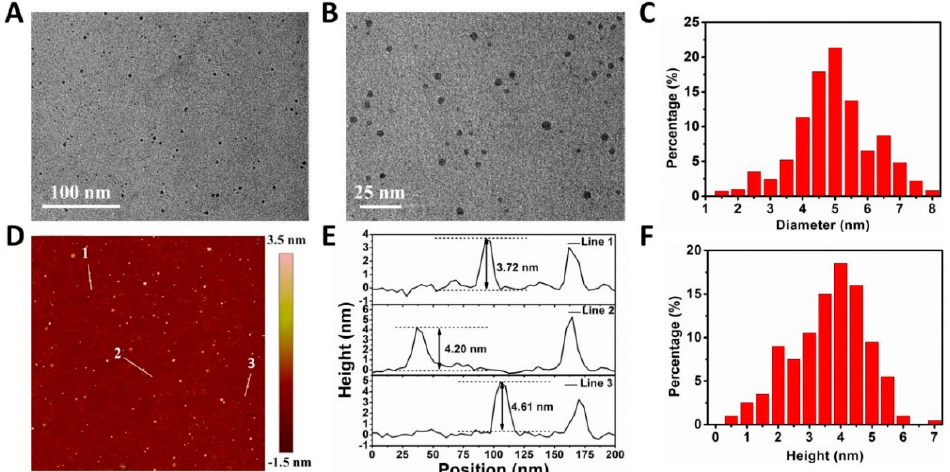
Figure 2. Characterizations of the NPs. ( A ) Transmission electron microscopy (TEM) image. ( B ) Magnified TEM image. ( C ) Statistical analysis of the size of 100 BPQDs-PEG-FA / DOX according to the TEM images. ( D ) Atomic force microscopy (AFM) image of BPQDs-PEG-FA / DOX. ( E ) Height profiles along the white lines in D. ( F ) Statistical analysis of the size of 100 BPQDs-PEG-FA / DOX based on the AFM images.